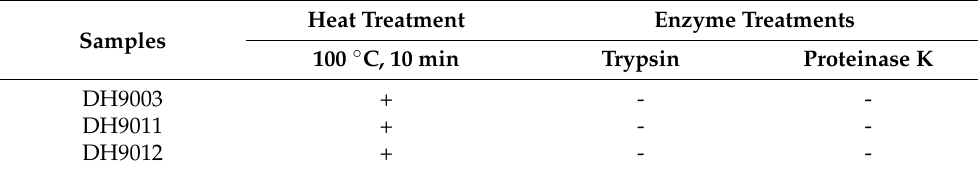
Table 1. Antimicrobial stability of bacteriocins produced by LAB under different treatments. Samples